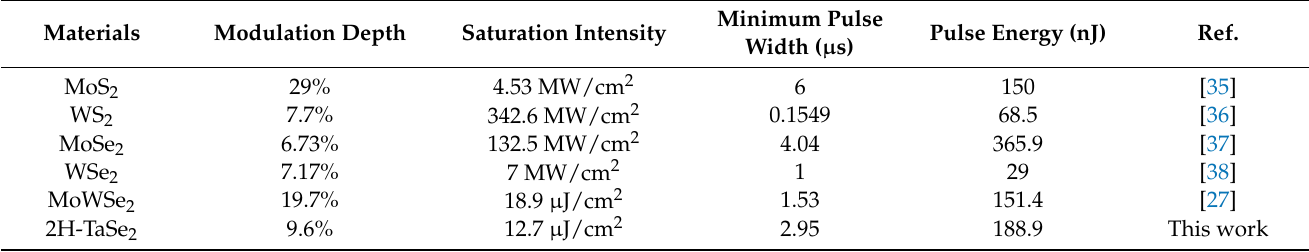
Table 1. Typical Q-switched EDF lasers using common transition metal dichalcogenides (TMDs) as saturable absorbers (SAs).